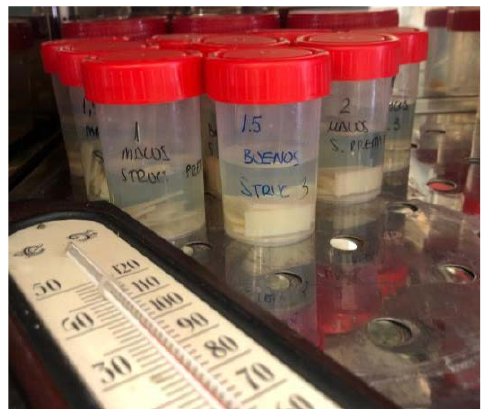
Figure 2. Immersion in artificial saliva .